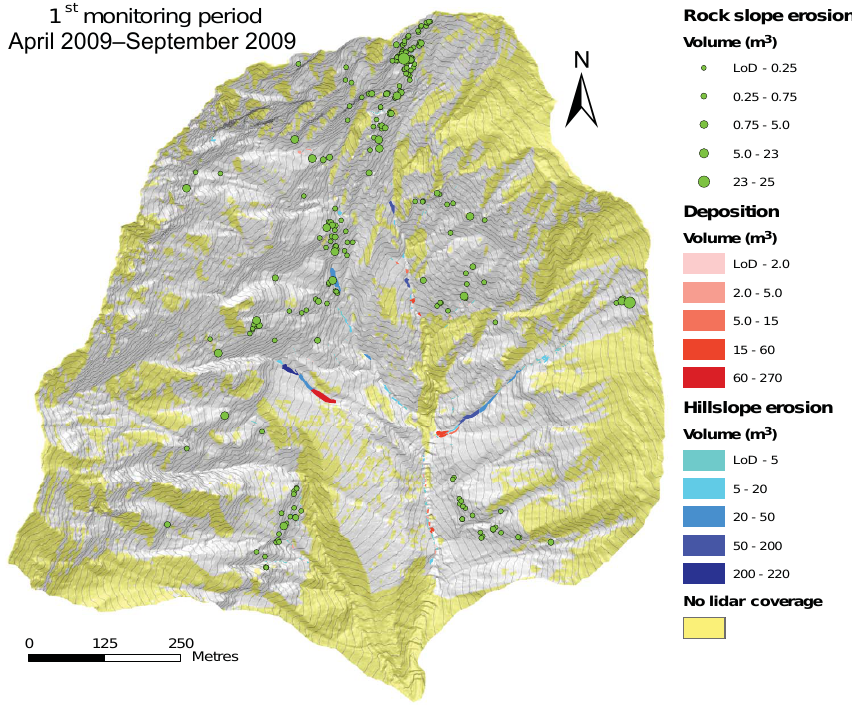
Figure 7. Geomorphic activity revealed by comparing the topographic differences of the two successive TLS surveys operated in April and August 2009. The sediment budgets for each subcatchment are detailed in Fig. 13.